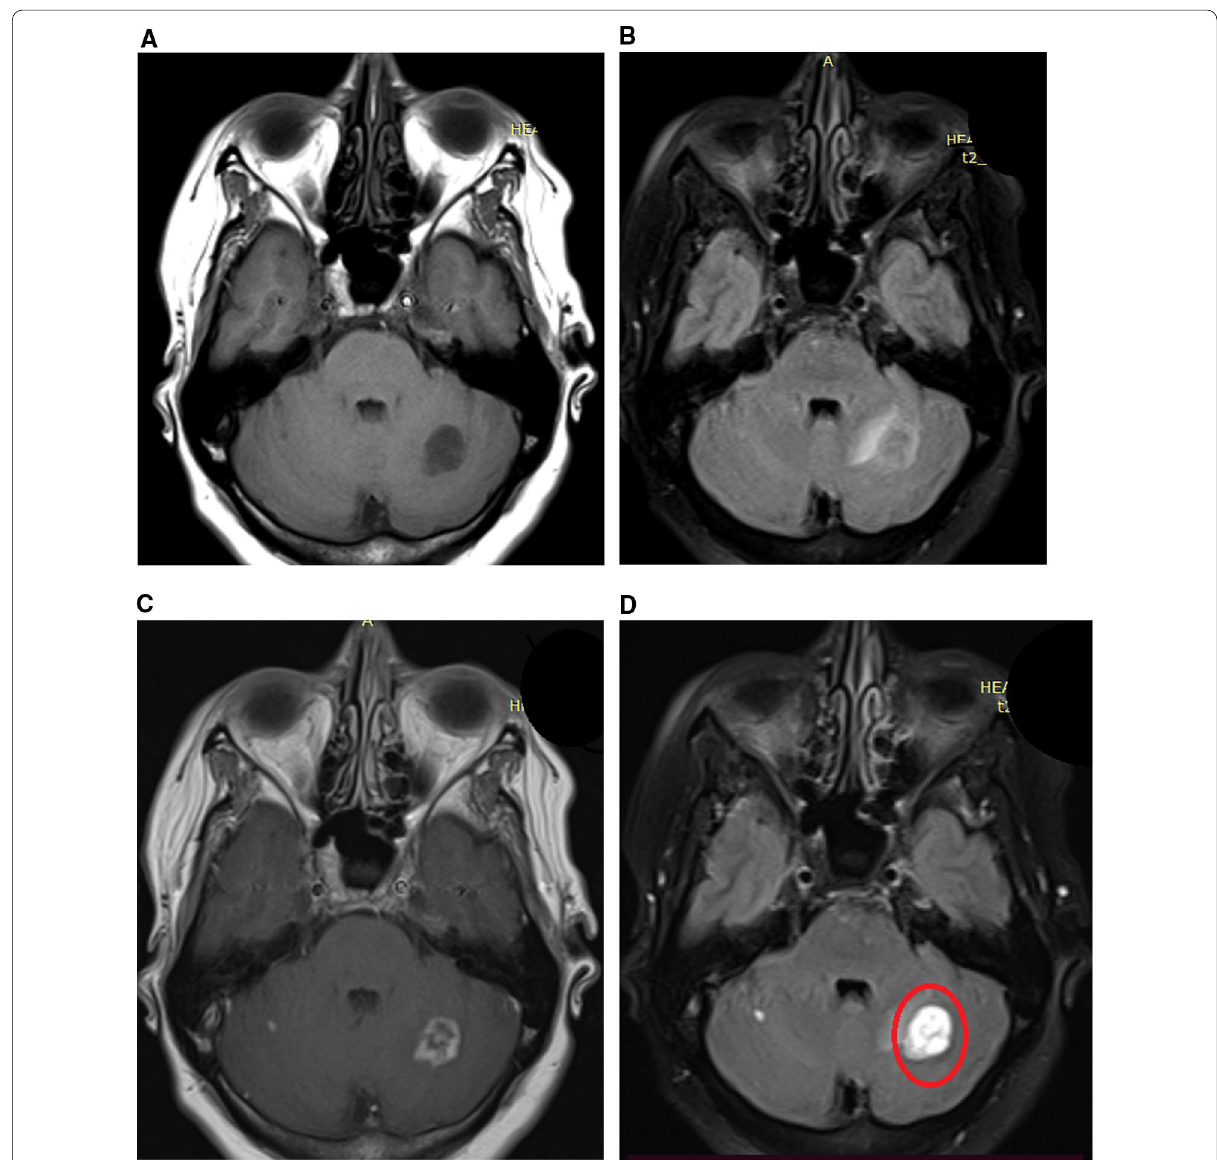
Fig. 5 A 52-year-old female patient with unknown primary. MRI study of the brain revealed a T1 hypo-intense lesion is noted at the left cerebellar hemisphere that shows minimal surrounding vasogenic edema on FLAIR. It shows better enhancement on DPC-FLAIR (D red circle) compared to the post-contrast T1WI (C). A Axial pre-contrast T1WI. B Axial FLAIR. C Axial CE-T1WI. D Axial